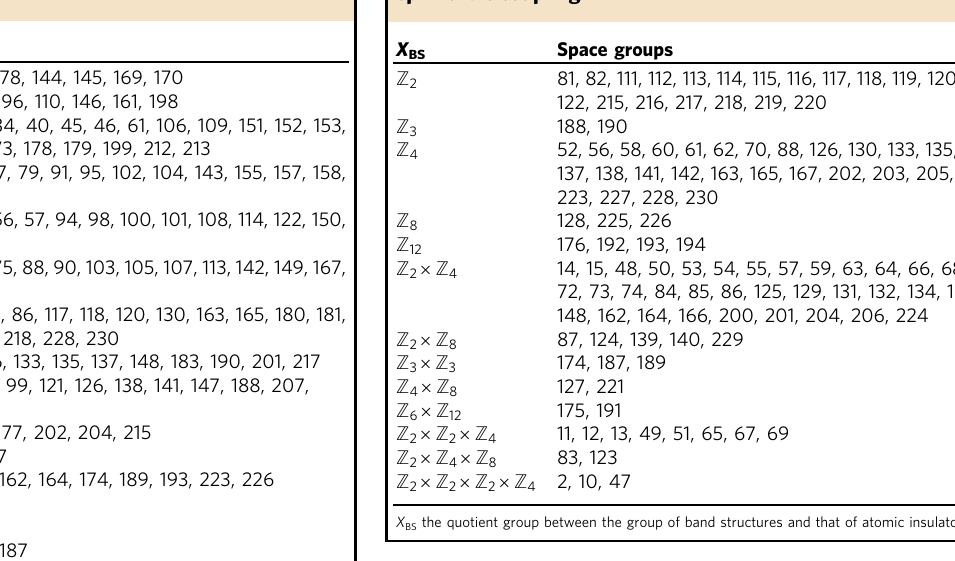
Table 2 Characterization of band structures for systems with time-reversal symmetry and negligible spin – orbit